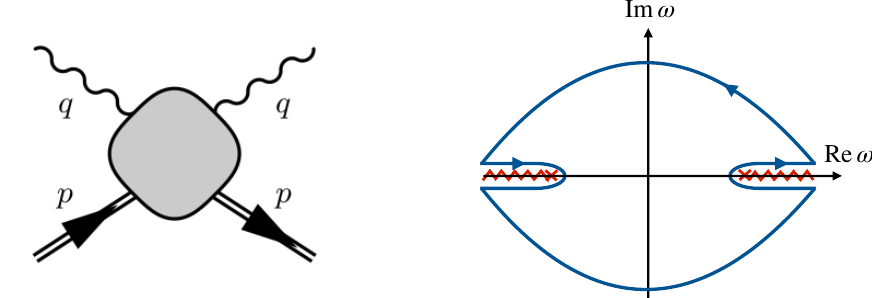
Figure 2: LH panel: The forward Compton Amplitude. RH panel: The analytic struc- ture for F – branch cuts starting from ω = ± 1, together with the contour used for 1 the dispersion